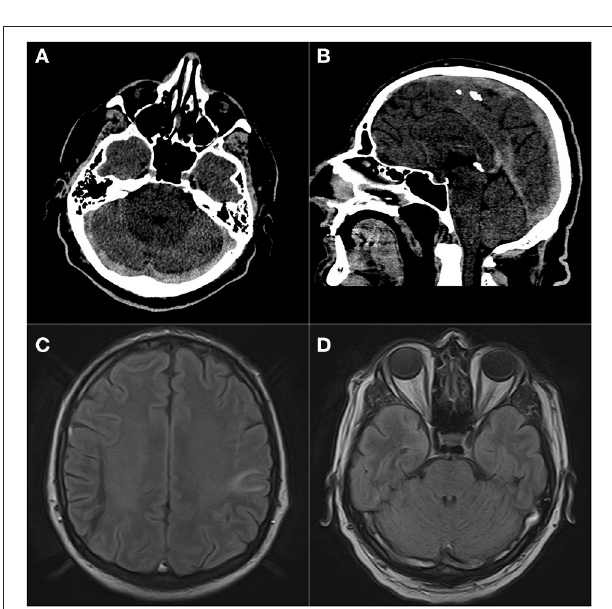
FIGURE 2 | Massive dural sinus thrombosis. Prominent hyperattenuation of transverse (A) , superior sagittal, and straight sinuses (B) on non-contrast CT. FLAIR images (C,D) of the same patient show abnormal high signal in dural sinuses and hyperintense area in the left parietal lobe consistent with venous infarct. Patient presented with impaired